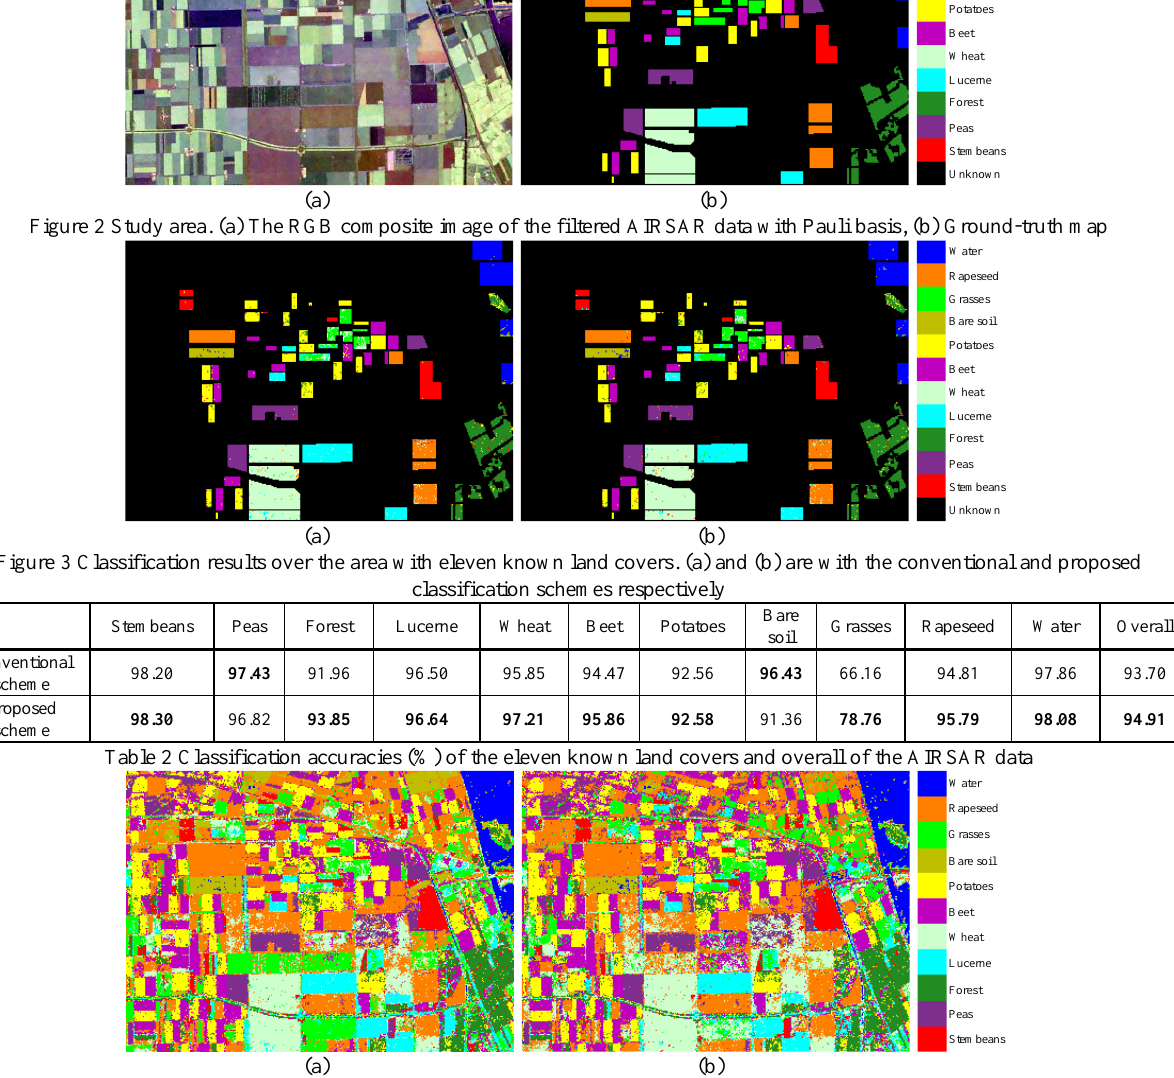
Figure 4 Classification results over the full-scene area. (a) and (b) are with the conventional and proposed classification schemes